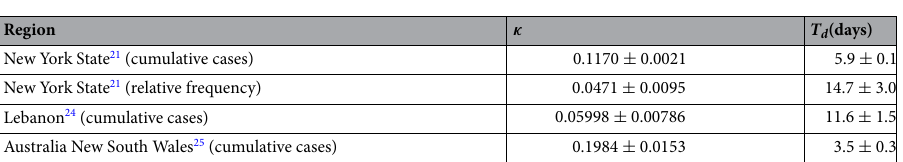
Table 2. Exponential growth rates, corresponding doubling times for various populations and measurements given available